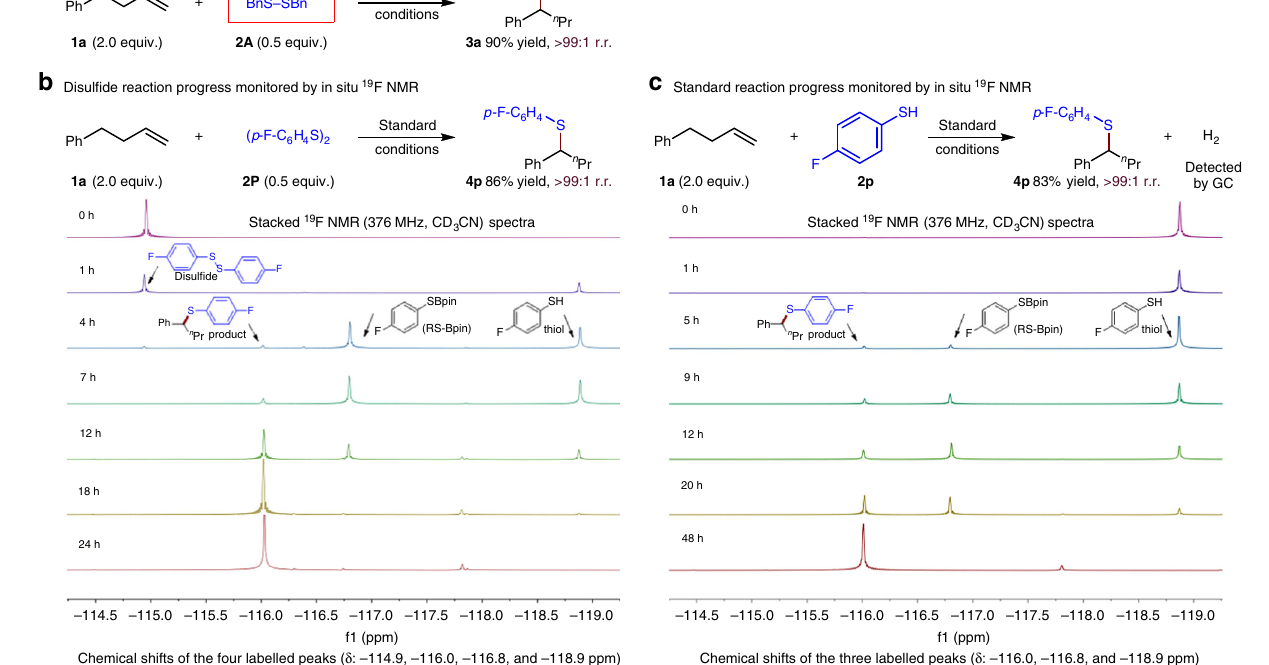
Fig. 6 Potential reactive intermediate of thiol. a Potential intermediates: disul fi de. b Disul fi de reaction progress monitored by in situ fl uorine-19 nuclear magnetic resonance ( 19 F NMR) (376 MHz, CD 3 CN). c Standard reaction progress monitored by in situ 19 F NMR (376 MHz, CD 3 CN) NATURE COMMUNICATIONS| (2019) 10:1752